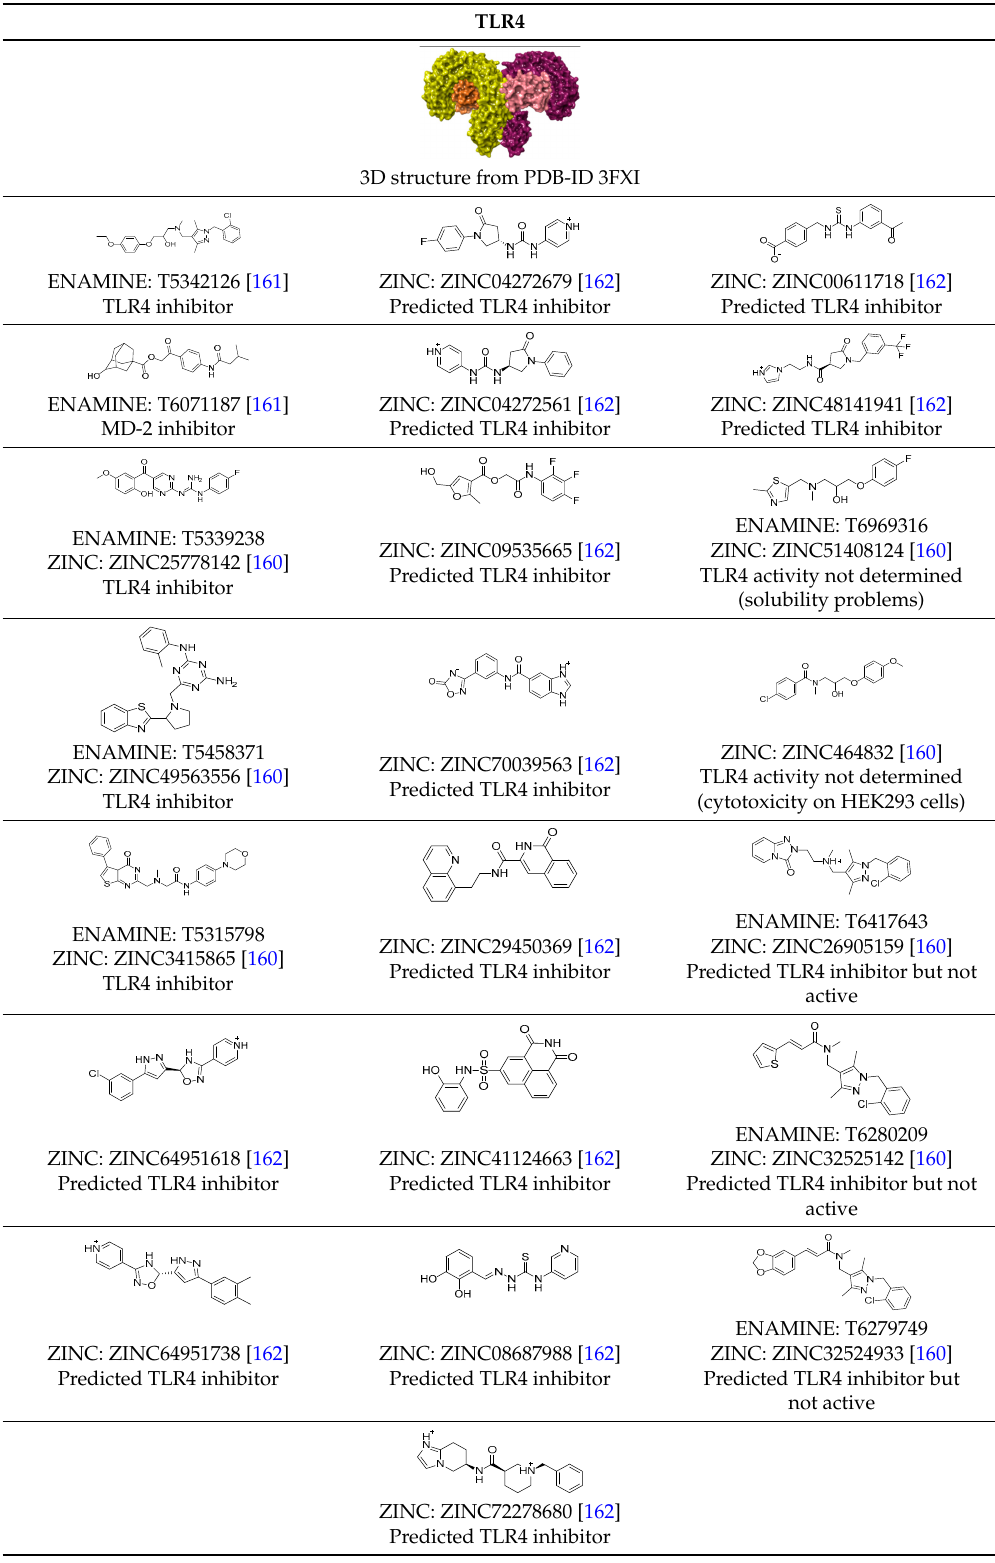
3D structure from PDB-ID 3FXI